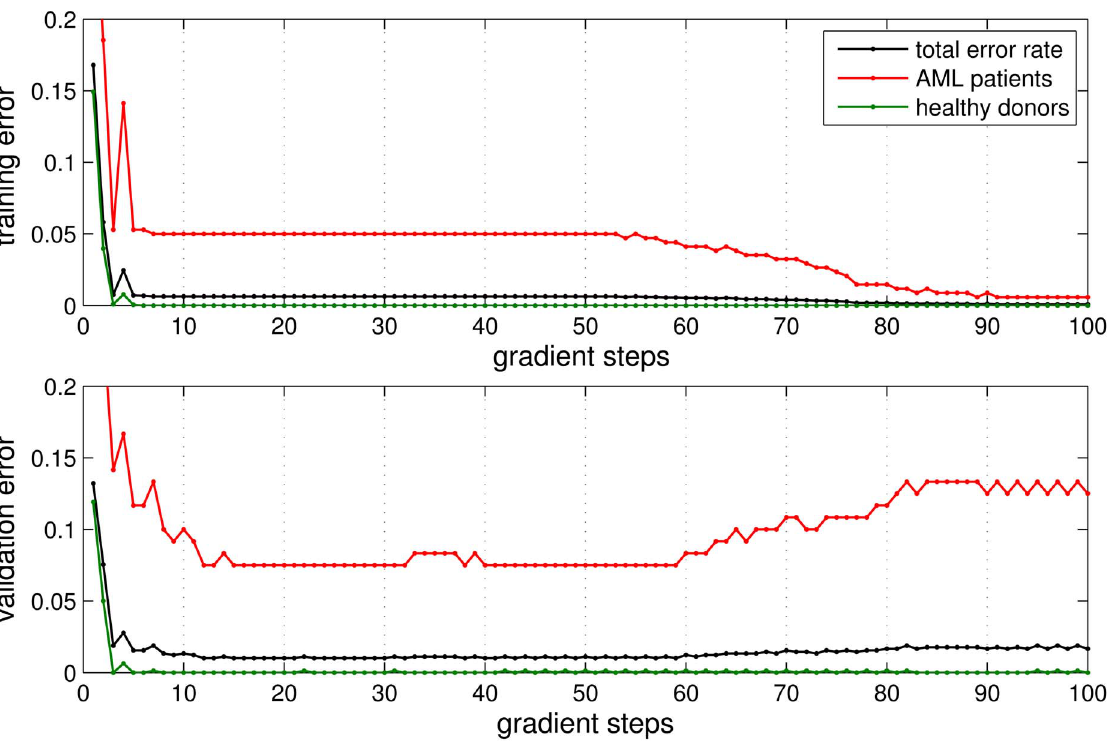
Figure 3. Learning curves in the validation procedure. Class specific and total error rates of Nearest Prototype Classification, corresponding to H ~ 0 in Eq. (8), on average over 50 randomized validation runs. The upper panel corresponds to the performance in the respective training set, the lower panel displays error rates with respect to the validation set. The curves correspond to including patient m ~ 116 in training or validation set. doi:10.1371/journal.pone.0059401.g003 influence of the initial configuration of the GMLVQ system. In each run, 40 gradient steps were performed with waypoint averaging and step size control as described above. The final test set scores were obtained on average over the 50 randomized training runs.